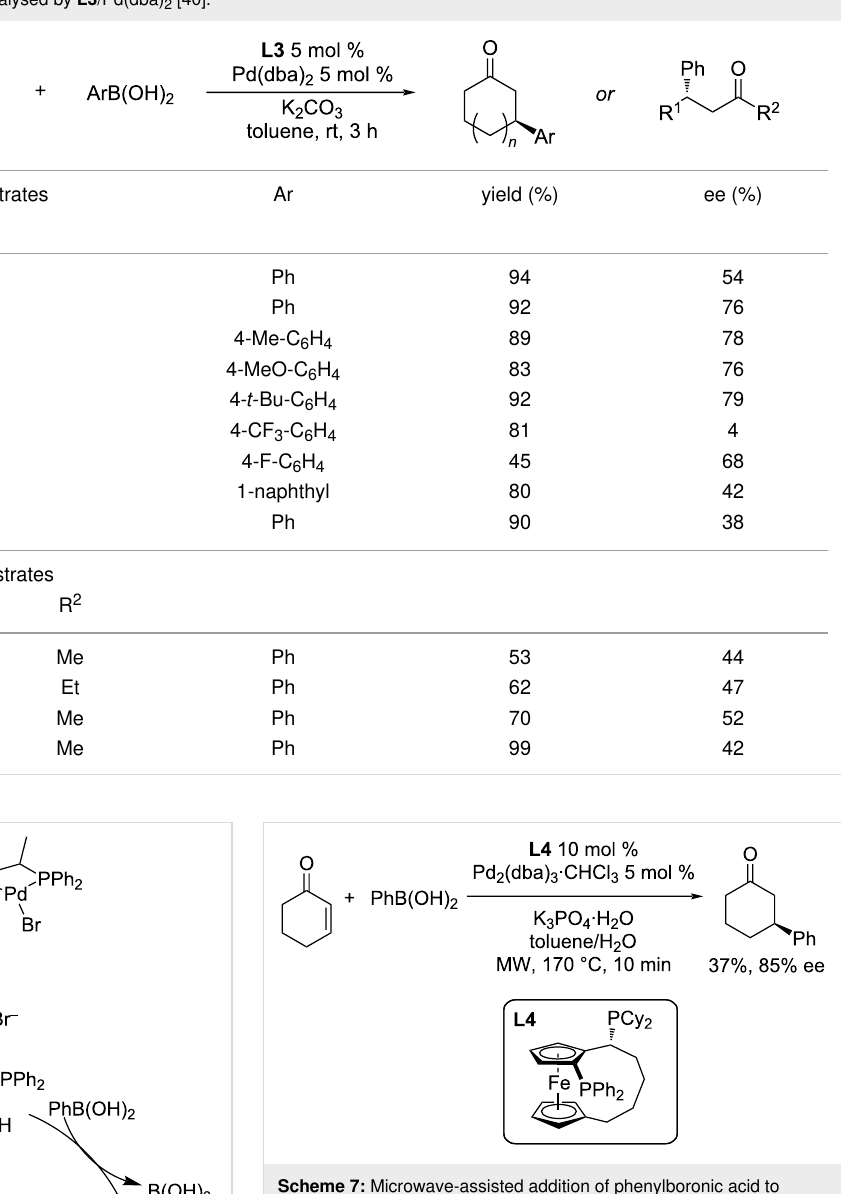
Table 10: Additions to different enones catalysed by L3 /Pd(dba) 2